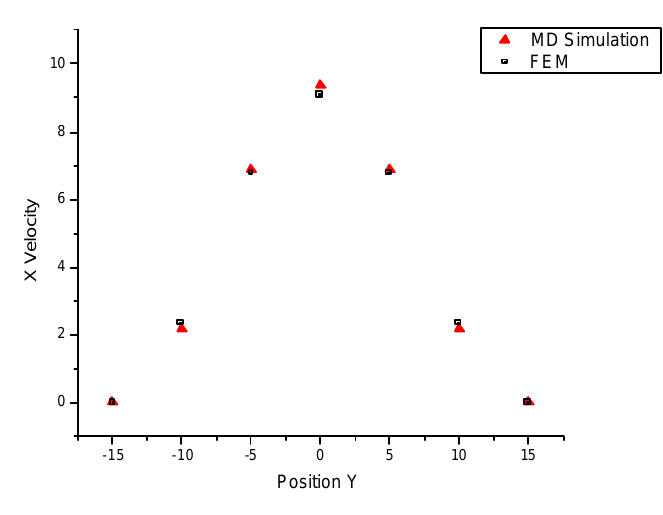
Figure 7. X velocity profile at position x=100 in Case 3